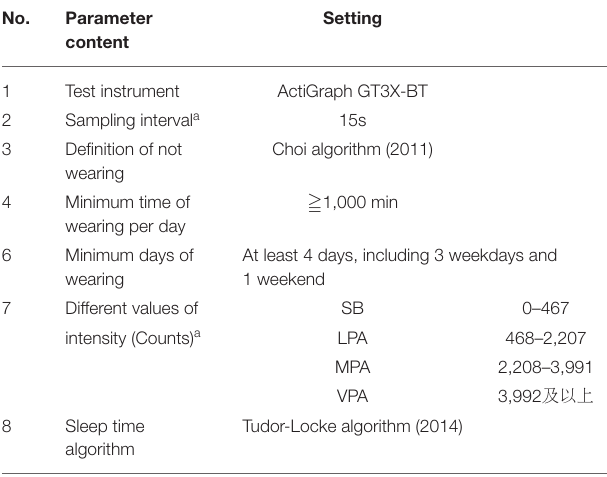
TABLE 2 | Measurement parameter settings list of